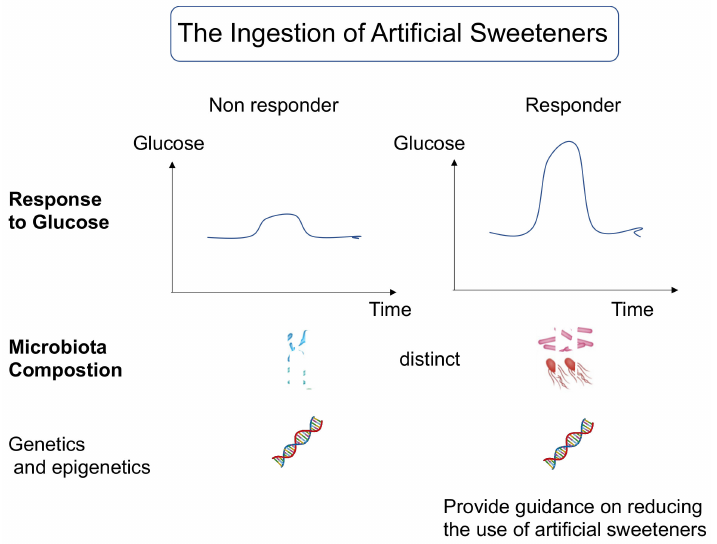
Figure 3. Questioning the intake of artificial sweeteners may be an important issue in nutritional guidance in the near